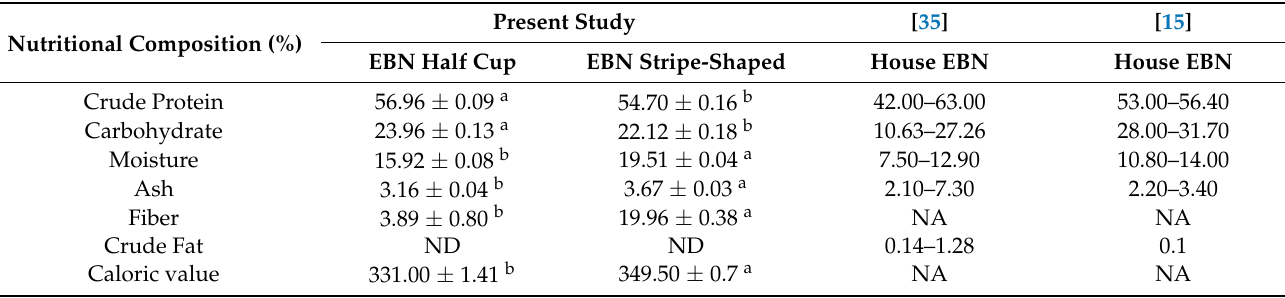
Table 3. Proximate composition and total dietary fiber content of the half cup and stripe-shaped EBN. Nutritional Composition